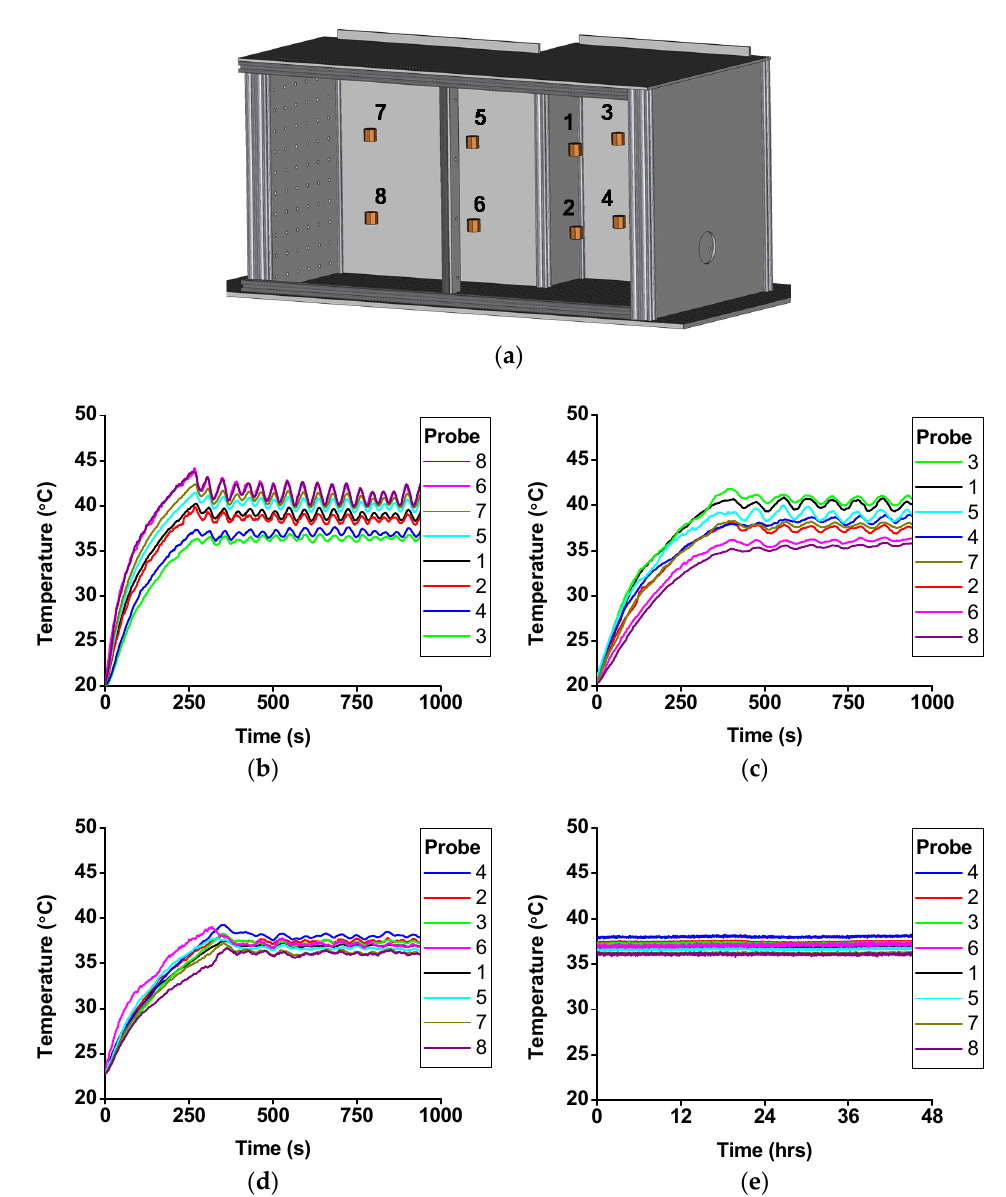
Figure 2. Temperature in the upright enclosure with and without baffle panels. ( a ) Thermocouples were placed at 8 locations in the enclosure. Probes 2, 4, 6, and 8 were 15 cm above the table, while probes 1, 3, 5, and 7 were 30 cm above the table. Probes 1, 2, 5, 6, 7, and 8 were 17 cm from front of the box, while probes 3 and 4 were 38 cm from the front. The heater feedback temperature sensor was positioned at the same location as probe 2. No microscope was in the enclosure during the measurements. ( b ) Temperature versus time for the enclosure without the air distribution baffle panels. The enclosure was initially at room temperature, and monitoring began after the heater setpoint was set to 37 °C. ( c ) Temperature versus time for the enclosure with the air distribution baffle panels. ( d ) Temperature versus time for the enclosure with upper half of air supply baffle holes closed (top 6 rows). ( e ) Temperature versus time for enclosure over 48 h with the same baffle configuration as Figure 2d.